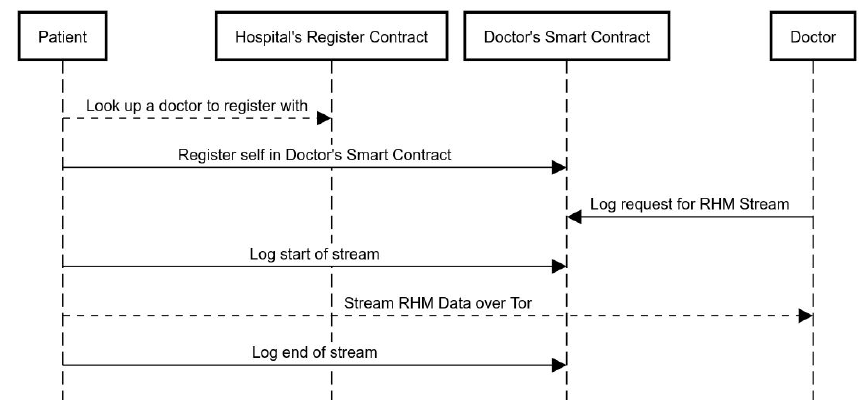
Figure 2. Sequence diagram of a remote health-monitoring instance, where a patient registers with the doctor and avails remote health-monitoring services. All interactions with the smart contract represent transactions. Dashed arrows represent off-chain interactions over Tor hidden services.